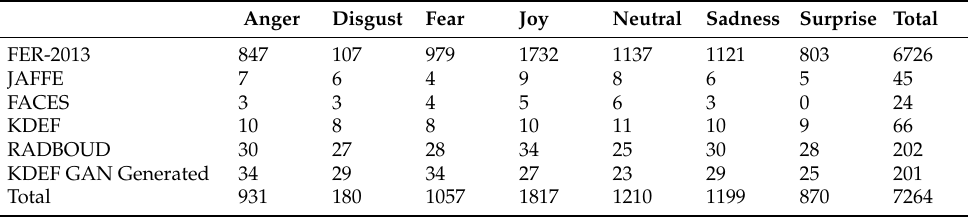
Table 7. Testing Data (Model A).